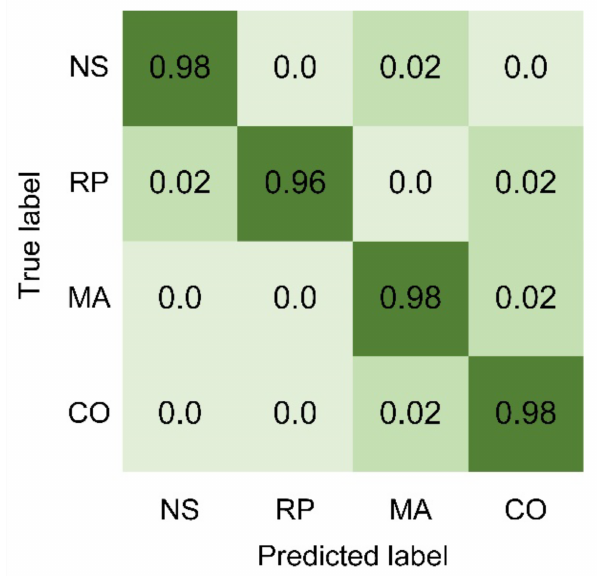
Figure 8. Classification confusion matrix.